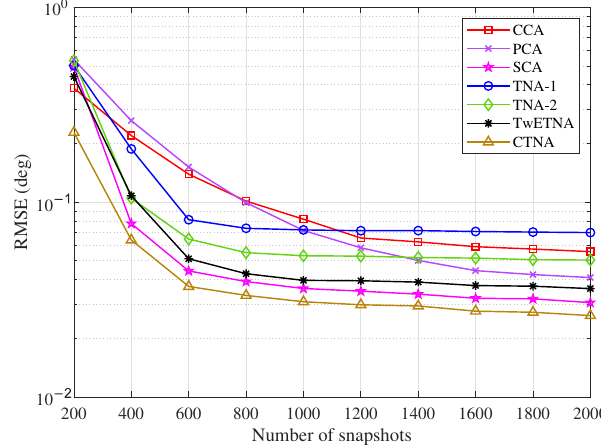
Figure 8. RMSE versus the number of snapshots, where SNR=0 dB, | c 1 | = 0.2.